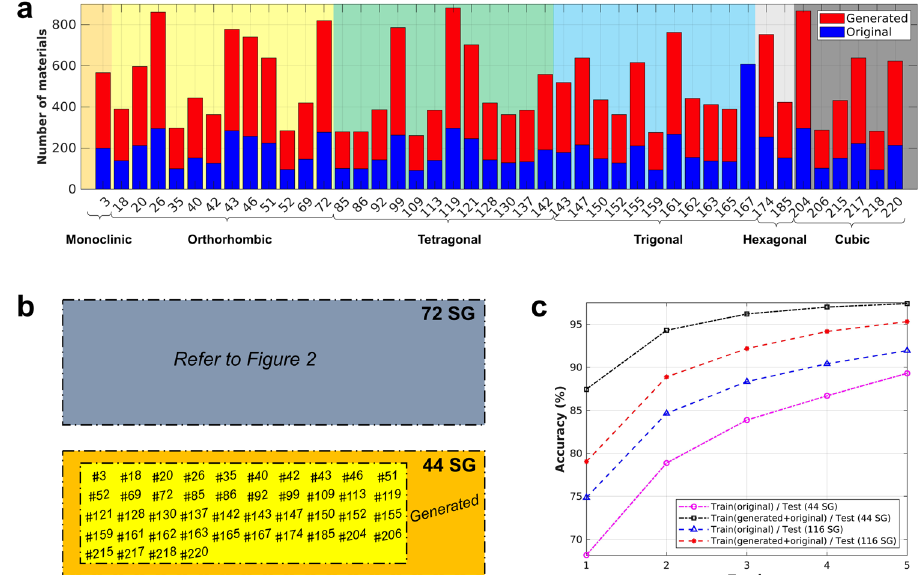
Fig. 5 Transfer learning performances for the new 44 SG dataset. a The population distribution of the diffraction pattern dataset for the new 44 SGs. b The usage of our dataset for the transfer learning experiments. c Transfer learning results with and without the data